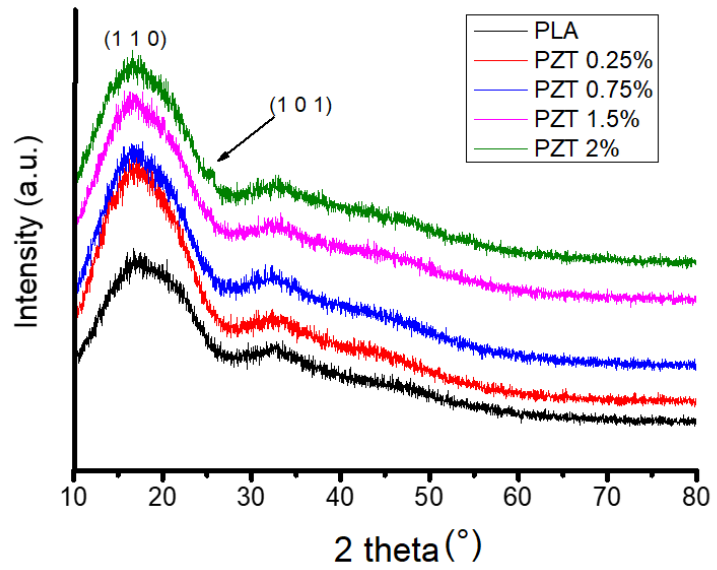
Figure 2. XRD spectra of neat PLA and nanocomposite PZT at different concentrations.